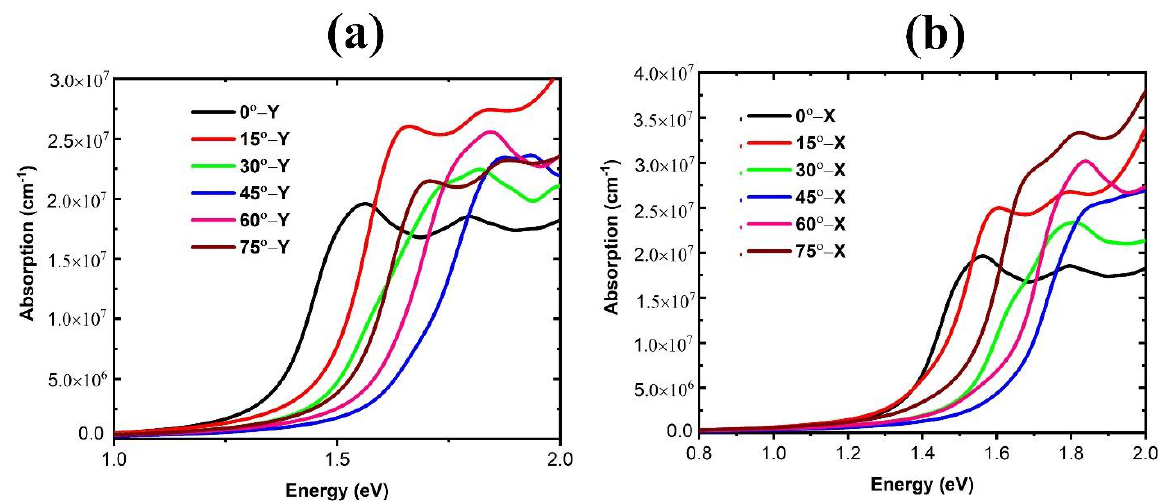
Figure 10. Optical adsorption spectrum of FAPbBr 3 perovskite for different FA rotations: ( a ) in Y mode and ( b ) in X mode.